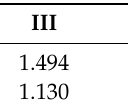
Table 2. Statistics for average distance deviations and standard deviations of global point clouds after optimization of registration.